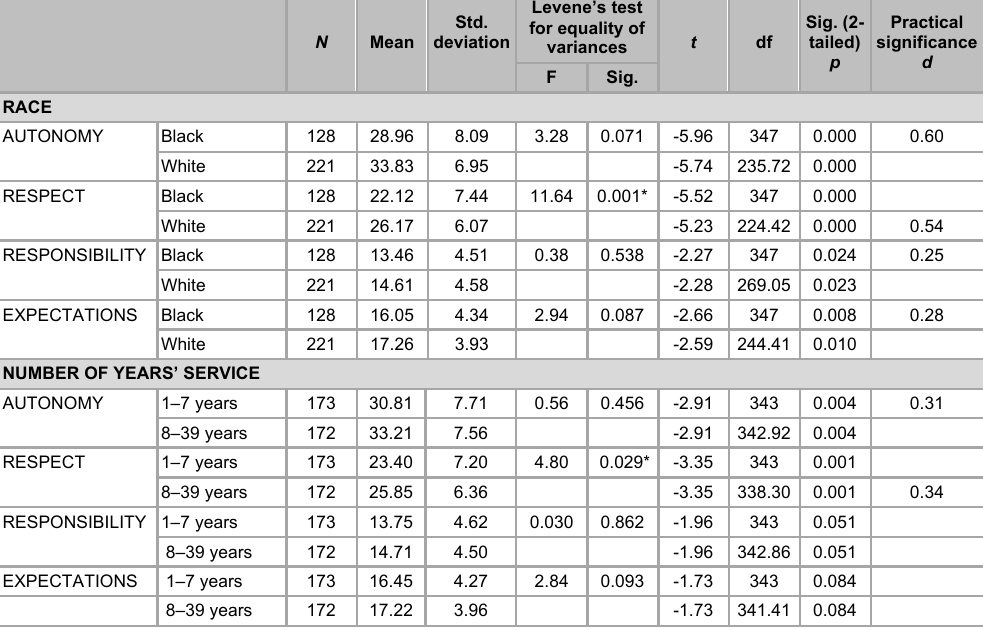
Students’ t-test: comparison of mean scores of race, number of years’ service and staff category in respect of employee